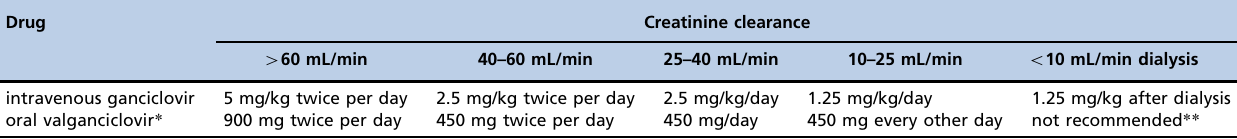
Table 3 - Antiviral drug doses recommended for treatment according to the glomerular filtration rate, which is estimated based on creatinine clearance